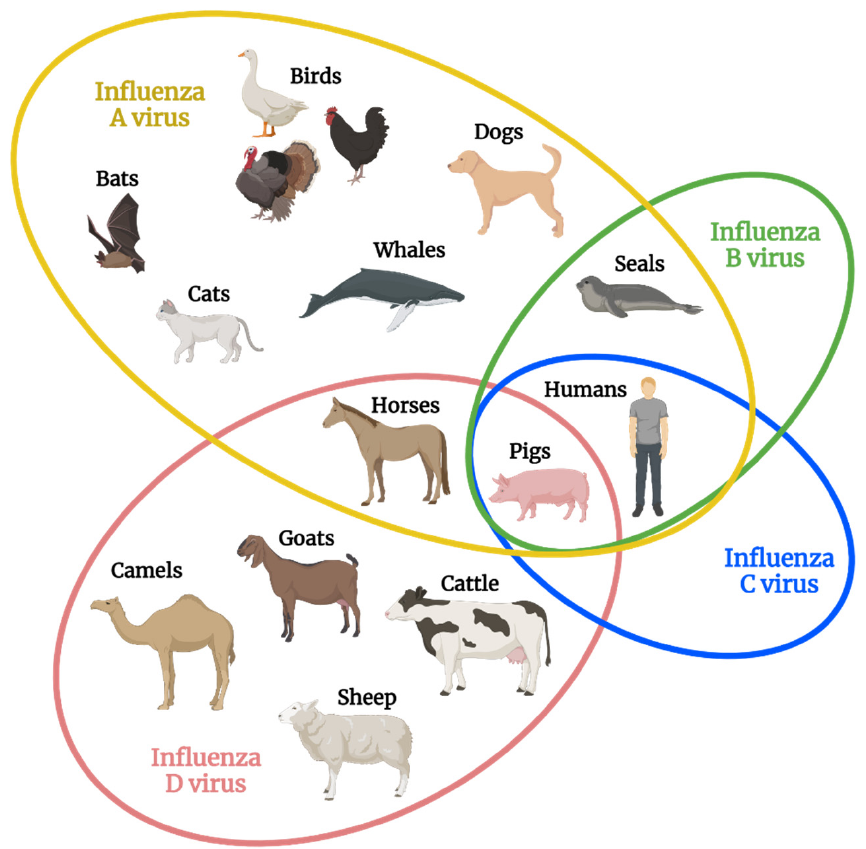
Figure 1. Natural host range of each influenza virus type. The major species of hosts that each influenza virus type naturally infects is shown, with some overlap existing across influenza virus types. Of note, pigs are the only species known to be infected by all four influenza virus types, and influenza D virus demonstrates the second widest host range behind influenza A virus [16]. Figure created with BioRender.com was adapted from ref. [16]: Kuchipudi and Nissly, 2018.